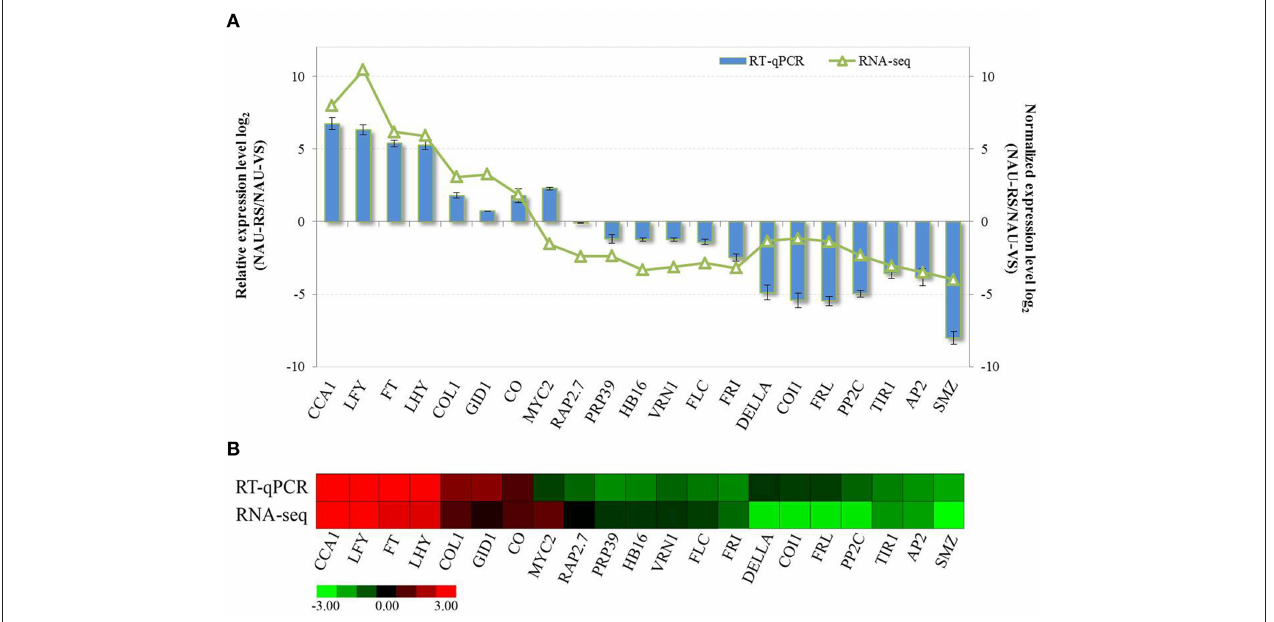
FIGURE 4 | The validation of expression levels of selected DEGs related to radish bolting and flowering. (A) The relative expression levels of selected DEGs were compared with the transcript abundances from DGE sequencing. (B) Heat map diagram of expression patterns of DEGs in radish. Red and green colors in indicate up- and down-regulated genes in NAU-RS library as compared with NAU-VS library,